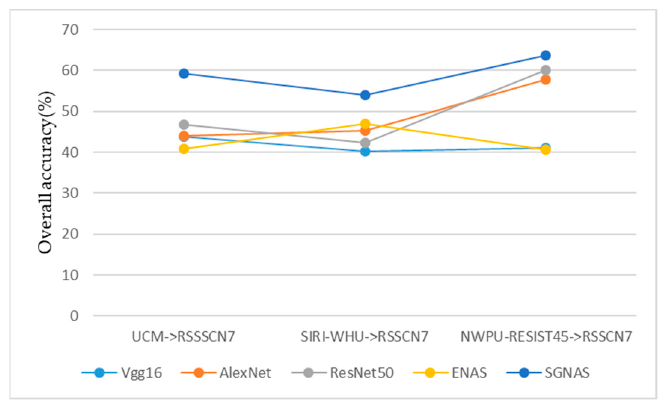
Figure 17. Overall accuracy values of each model on three cross-domain scenarios.